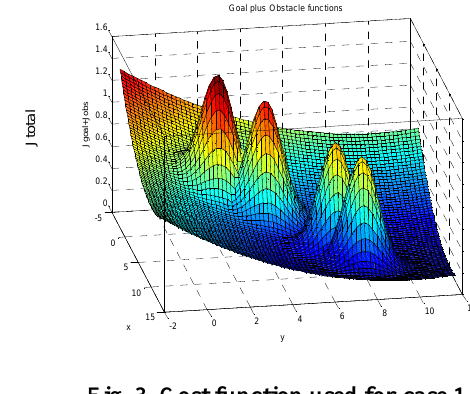
Fig. 3. Cost function used for case 1.